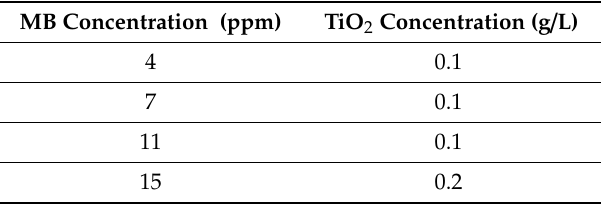
Table 4. Optimum conditions for PMR